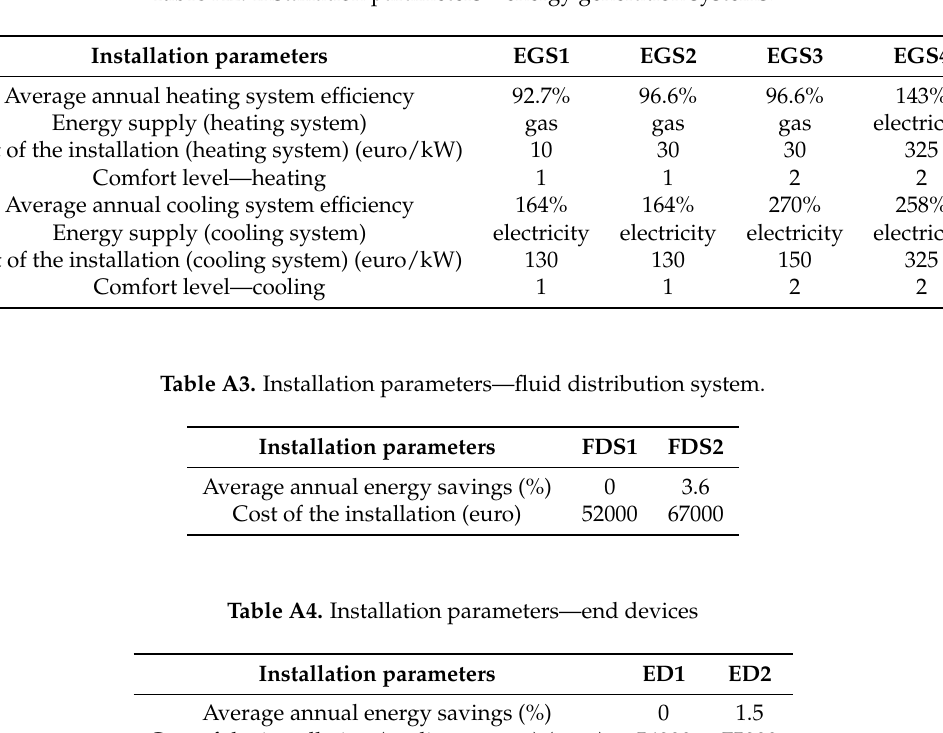
Table A2. Installation parameters—energy generation systems.